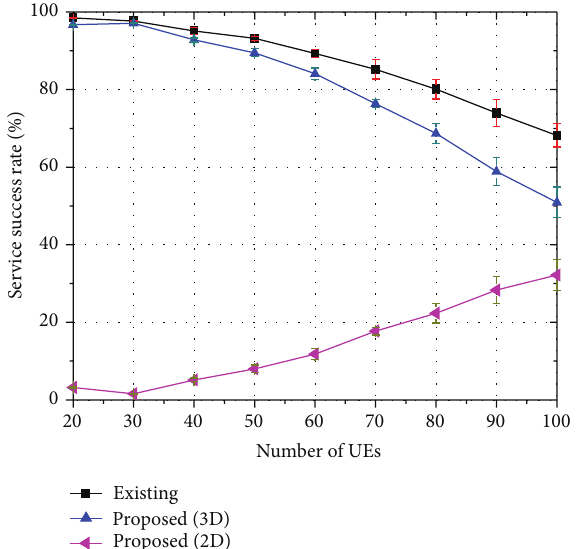
Figure 9: Service success rate of 32-viewpoint 3D A/V traffic ( 𝛽 = 1.8 ).